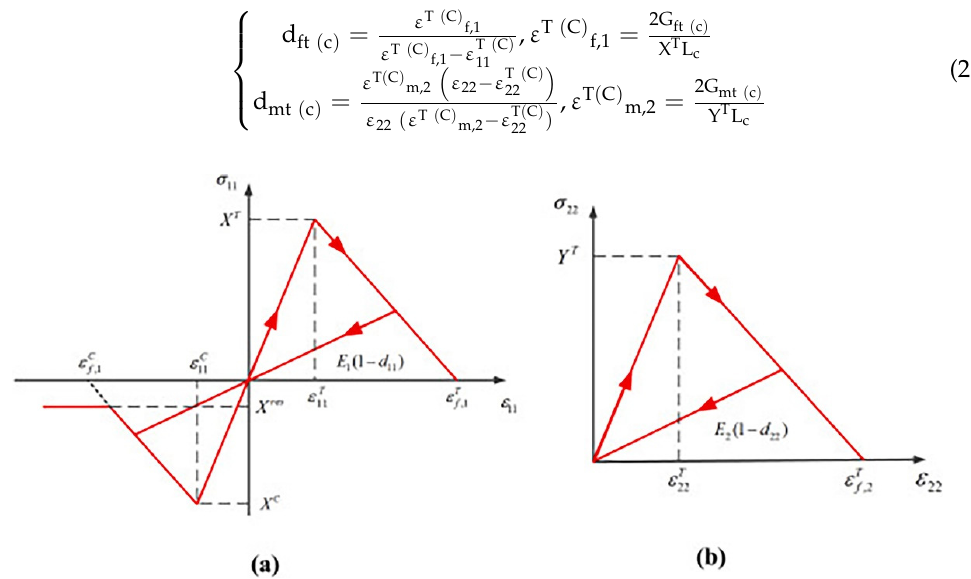
Figure 7. The evolution model of matrix tensile and compression damage is the same as